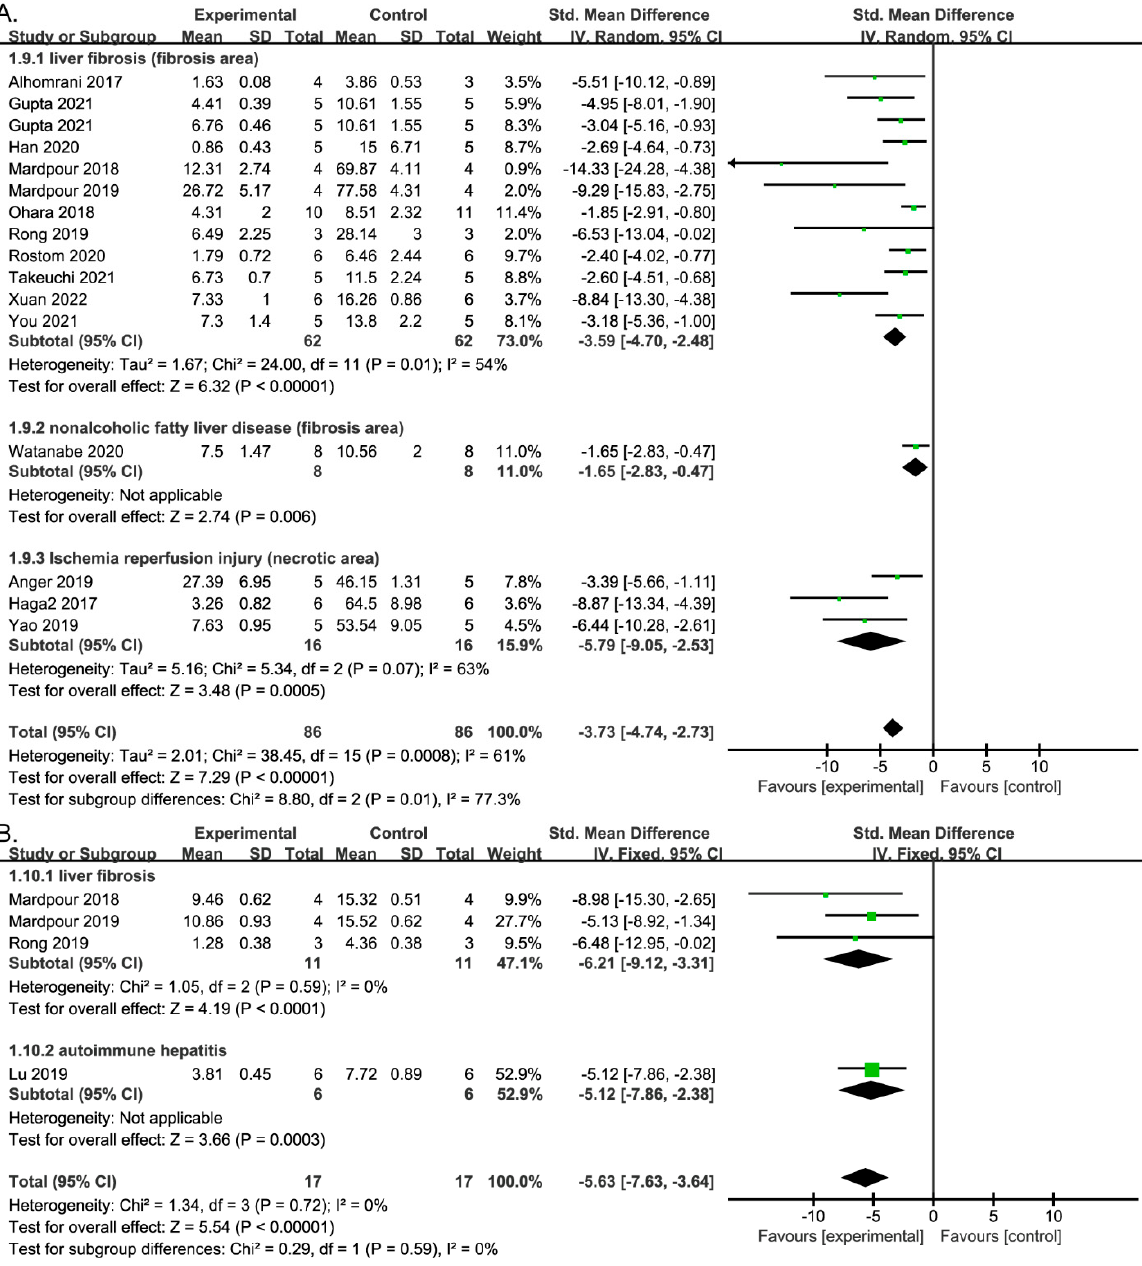
Figure 4. Forest plot of the efficacy of MSC-EV therapy on histological analysis. ( A ) Forest plot of the percentage of damage area; ( B ) Forest plot of Ishak’s score.